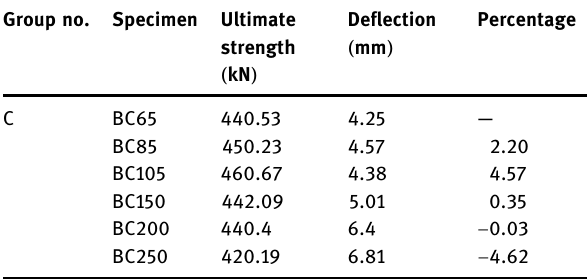
Table 4: Ultimate strength and de fl ection of midspan of Group C Group no. Specimen Ultimate